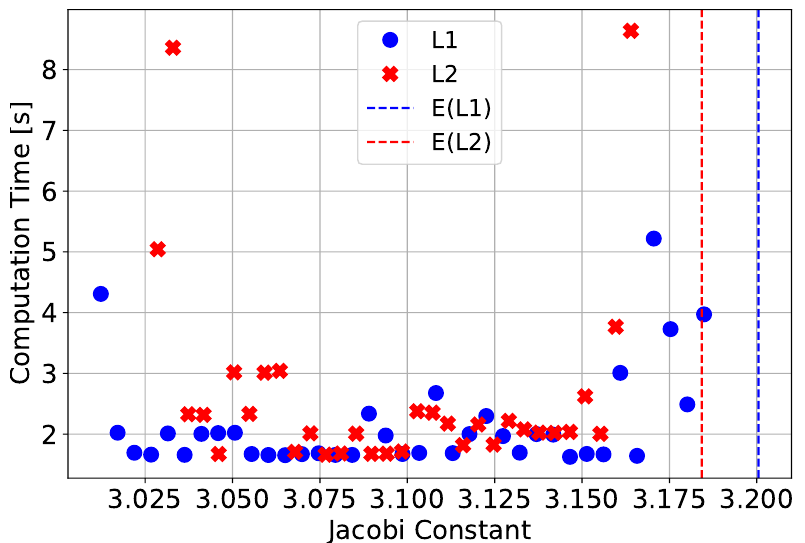
Figure 11. Computational time of the TFC method for the solution of “northern” Halo orbits around L1 and L2 plotted in Figure 9. At first glance, it can easily be seen that the computation of these orbits took around twice as long to compute as the Lyapunov orbits. One cause of the increased computation time is that the system of equations increased since more points and basis functions were need in the computation of these